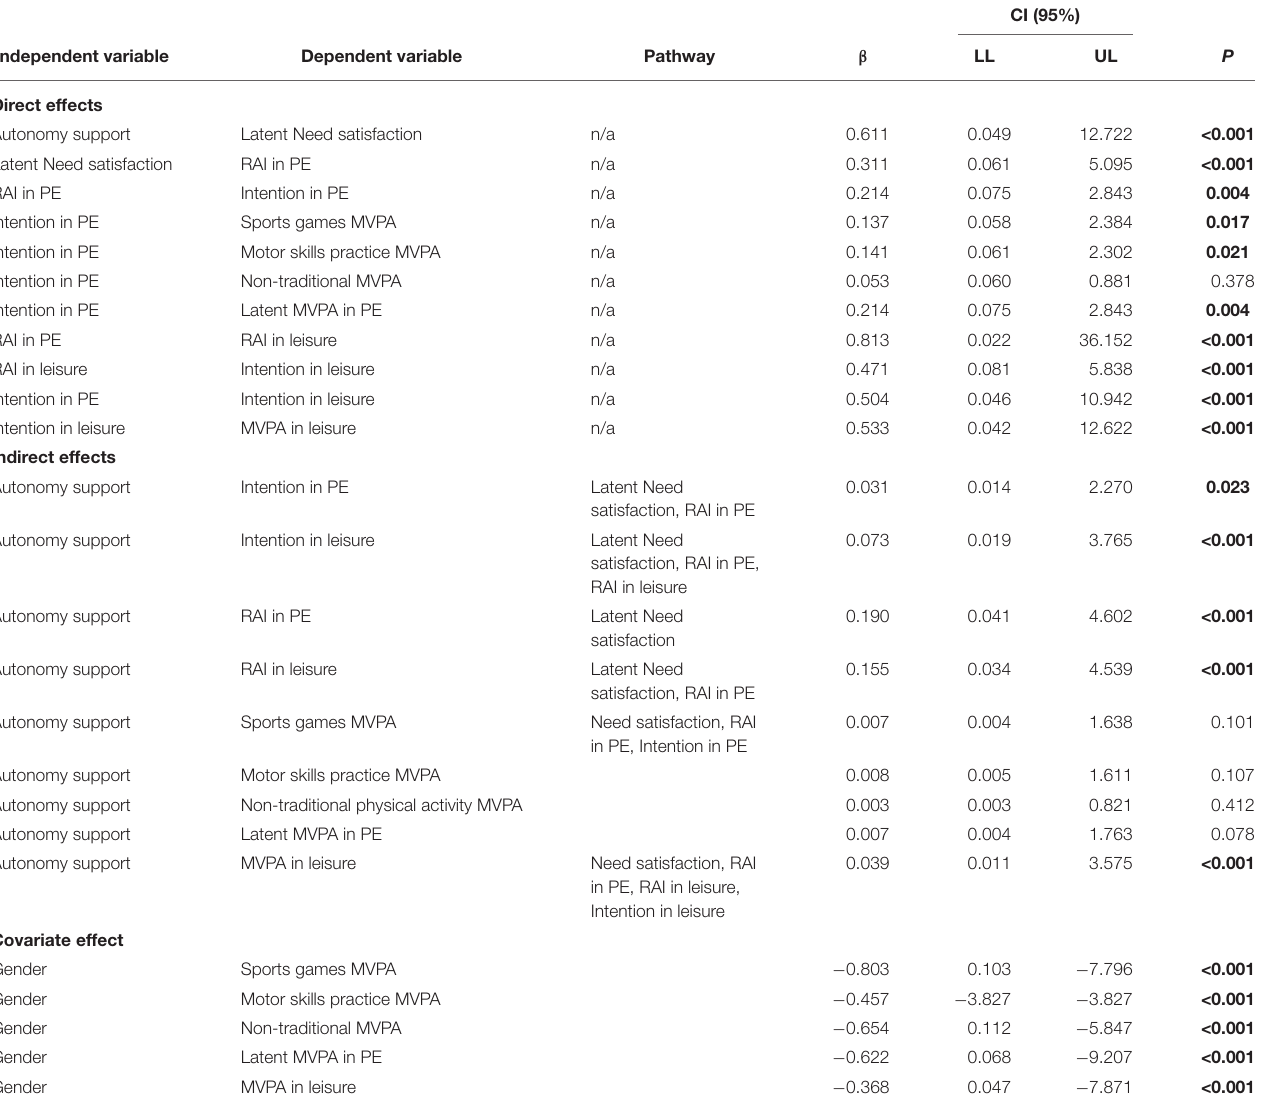
TABLE 3 | Direct and indirect effects across five models predicting MVPA in sports games, motor skills practice, non-traditional physical activity lessons, total MVPA in physical education and leisure time